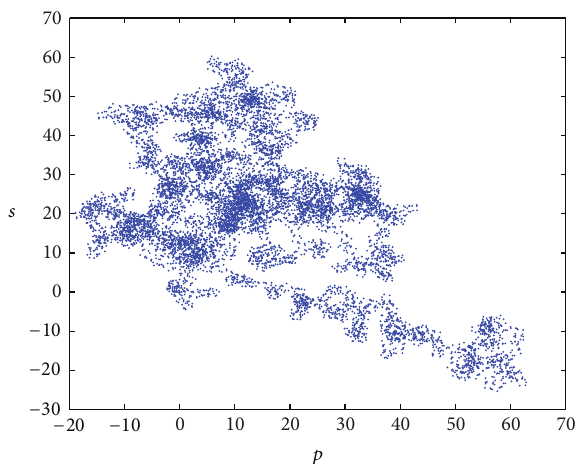
Figure 12: Plots versus 𝑠 2 = 0.1 and 𝑠 3 = 0.4 in new coordinates (𝑝,𝑠) space.